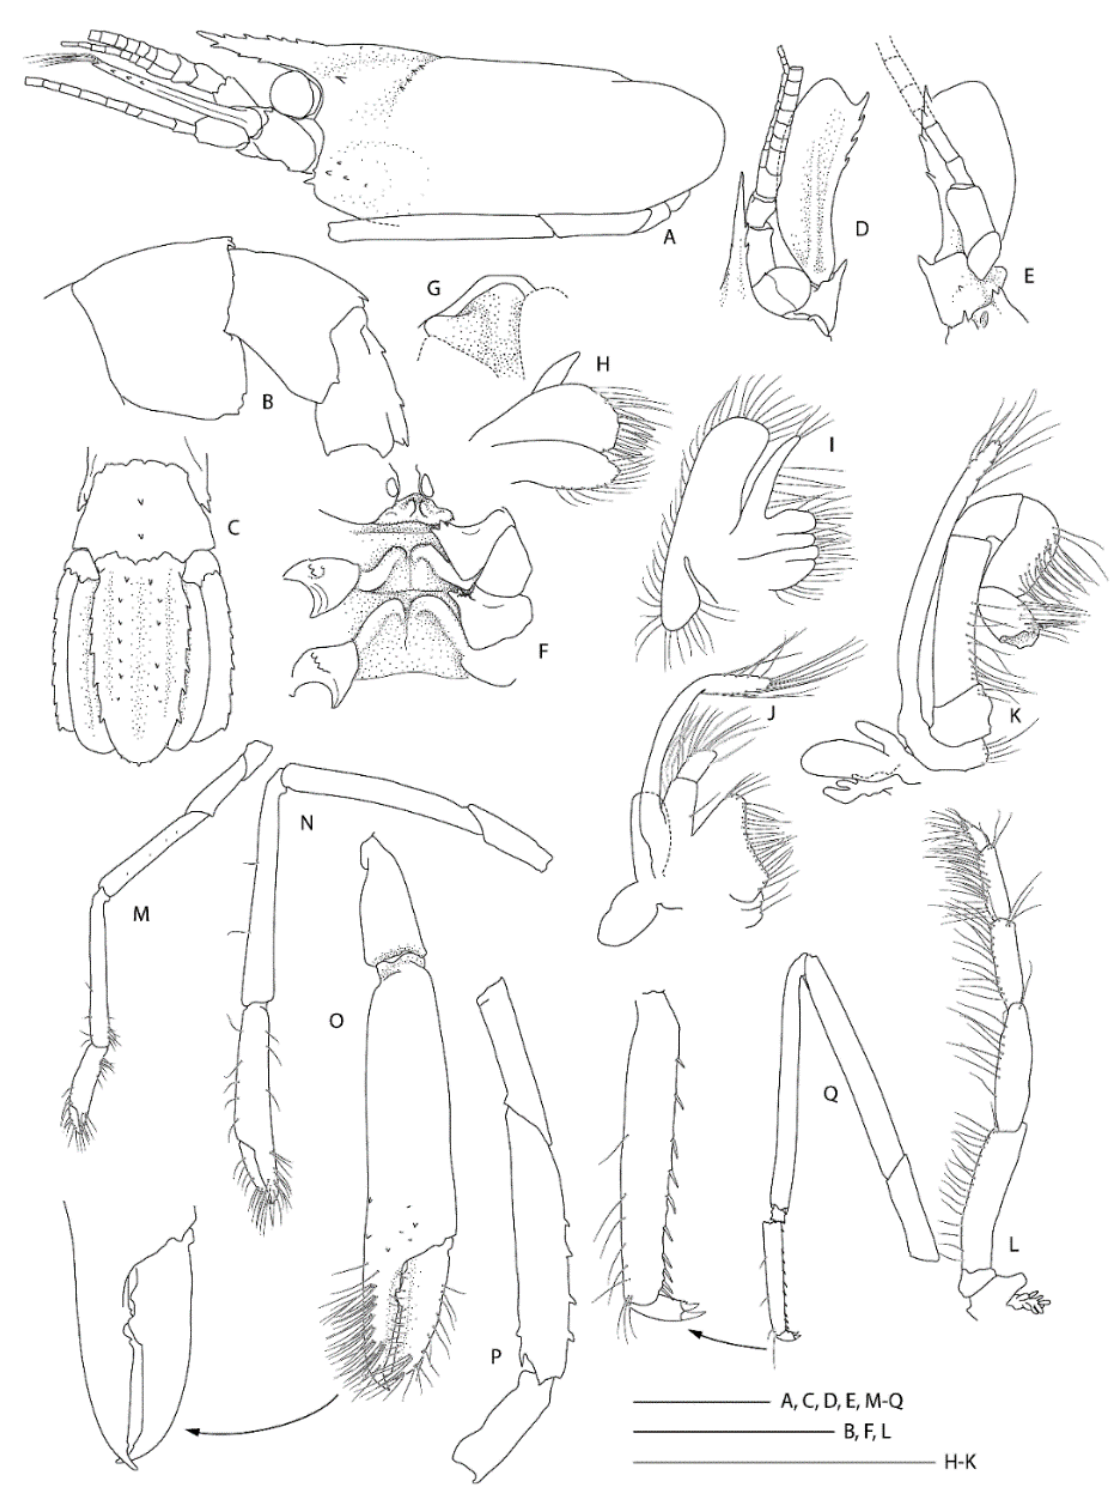
Figure 23. Spongicaris yaldwyni Bruce & Baba, 1973 [21] , holotype F (NMNZ CR.001888). ( A ) Anterior carapace and cephalic appendages, dorsal. ( B ) Pleonites 5 and 6, urosome and telson, dorsal. ( C ) Pleonites 4–6, urosome and telson, lateral. ( D ) Epistome and labrum, oblique ventral view. ( E ) Right antenna, ventral with detail of rotated mesial margin of basicerite. ( F ) Thoracic sternites 6–8 with coxae of pereiopods, ventral. ( G ) Left distal portion of P1, mesial. ( H ) Right P1, lateral. ( I , J ) Lose P4 or P5, lateral. Scale bars = 2 mm.